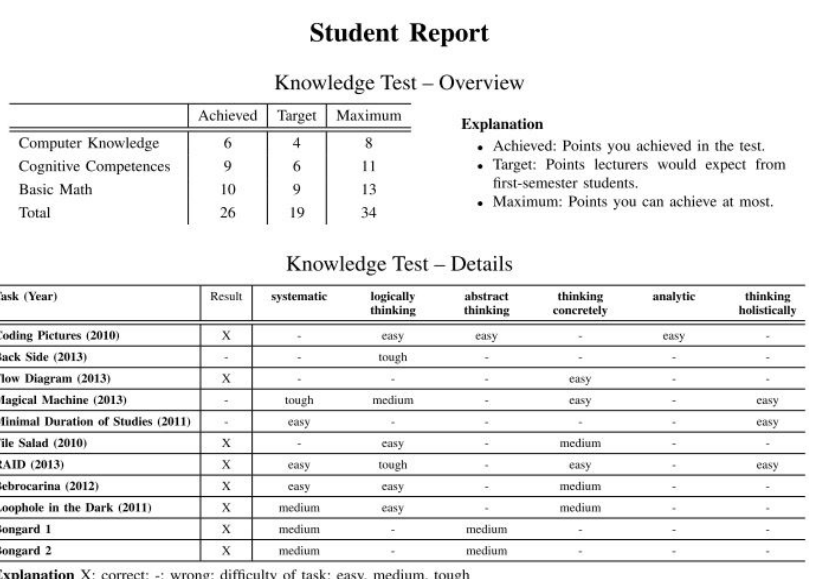
Fig. 4. Example evaluation for a